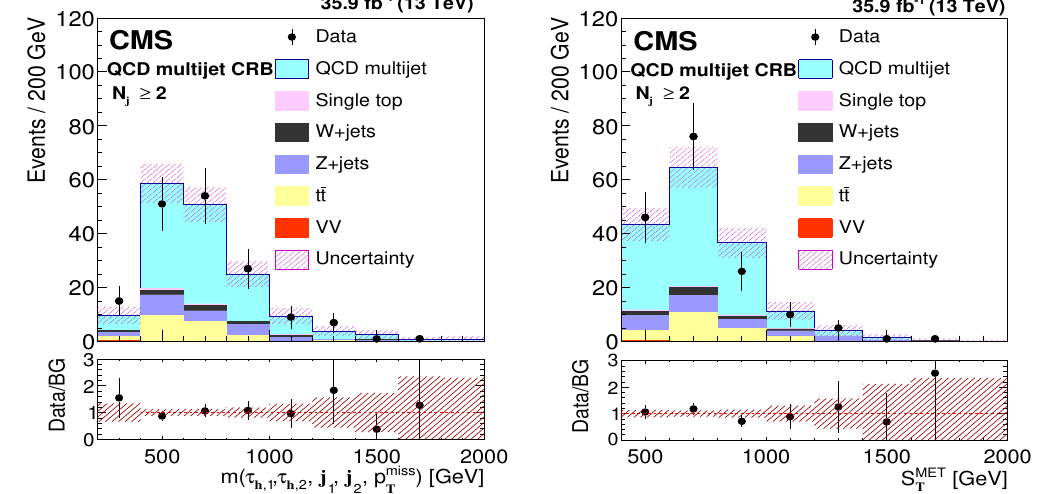
Figure 4 . QCD multijet background validation test, using the distributions in CR B ) (left) and S MET (right). The shape of the QCD background is found from m ( (cid:28) h ; 1 ; (cid:28) h ; 2 ; j 1 ; j 2 ; p miss T T data in the loose (cid:28) h region, CR A and then applied to CR B , de(cid:12)ned by p miss < 50 GeV and tight T (cid:28) h isolation. For both samples, the non-QCD contributions are estimated from simulation. Note that the normalizations match by construction. The bottom frame shows the ratio between the observed data in CR B and the total background